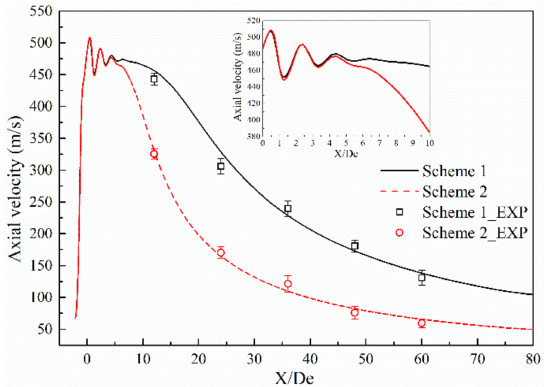
Figure 5. Comparison of axial velocity between the combustion experiment results and the numerical simulation